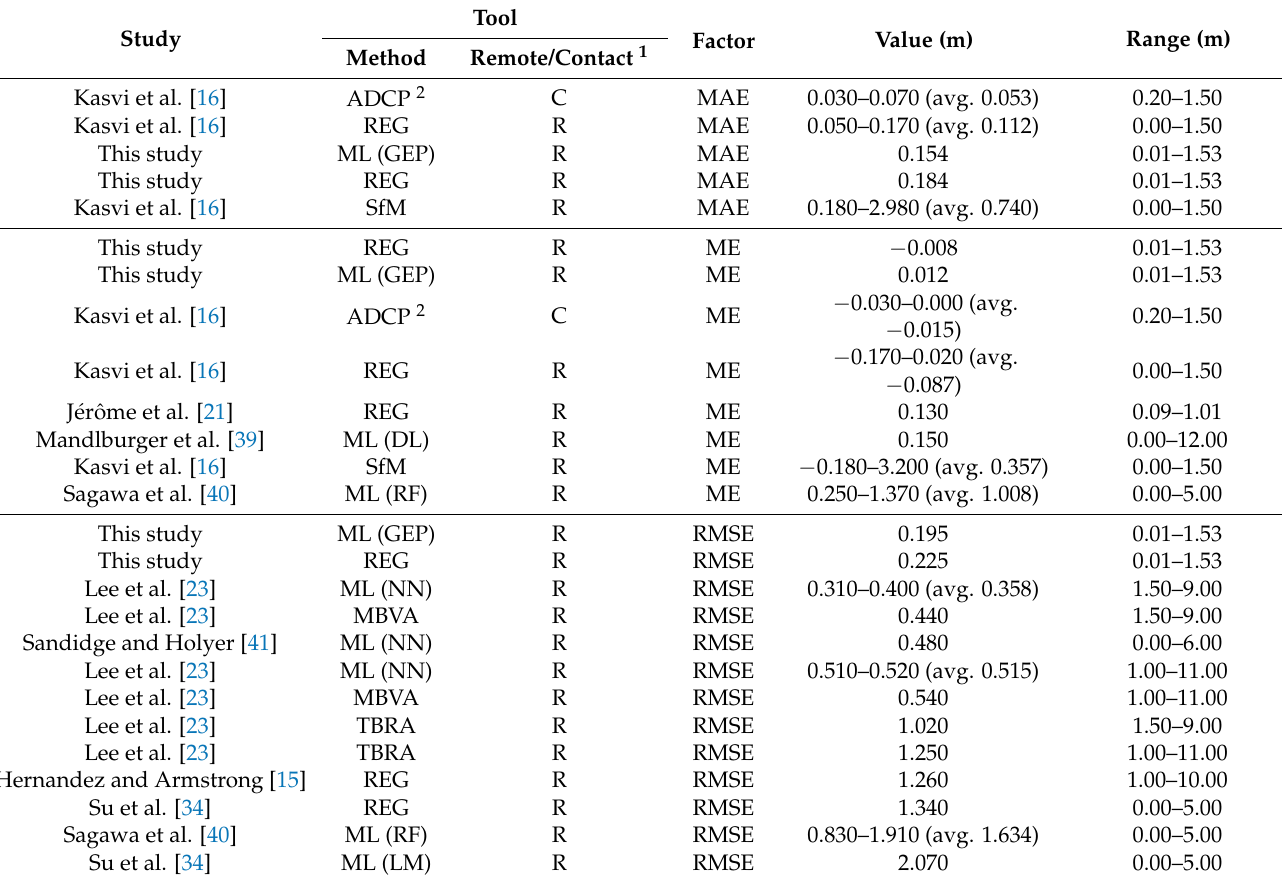
Table 6. Comparison of water depth retrieval results between this study and related